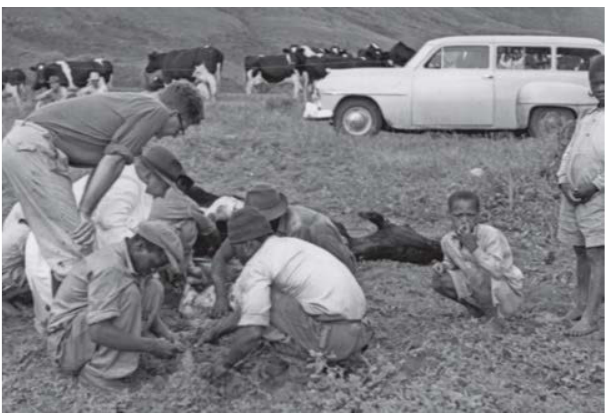
Figure 5: Typical working conditions on the rural farms